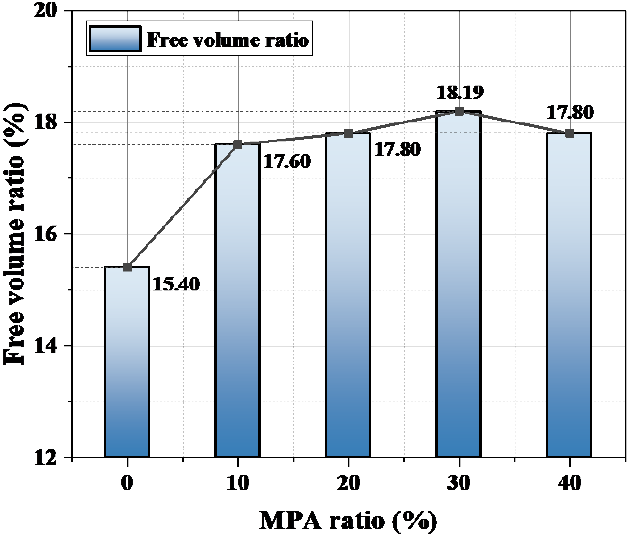
Figure 10. Effect of MPA content on the free volume of the blended system.